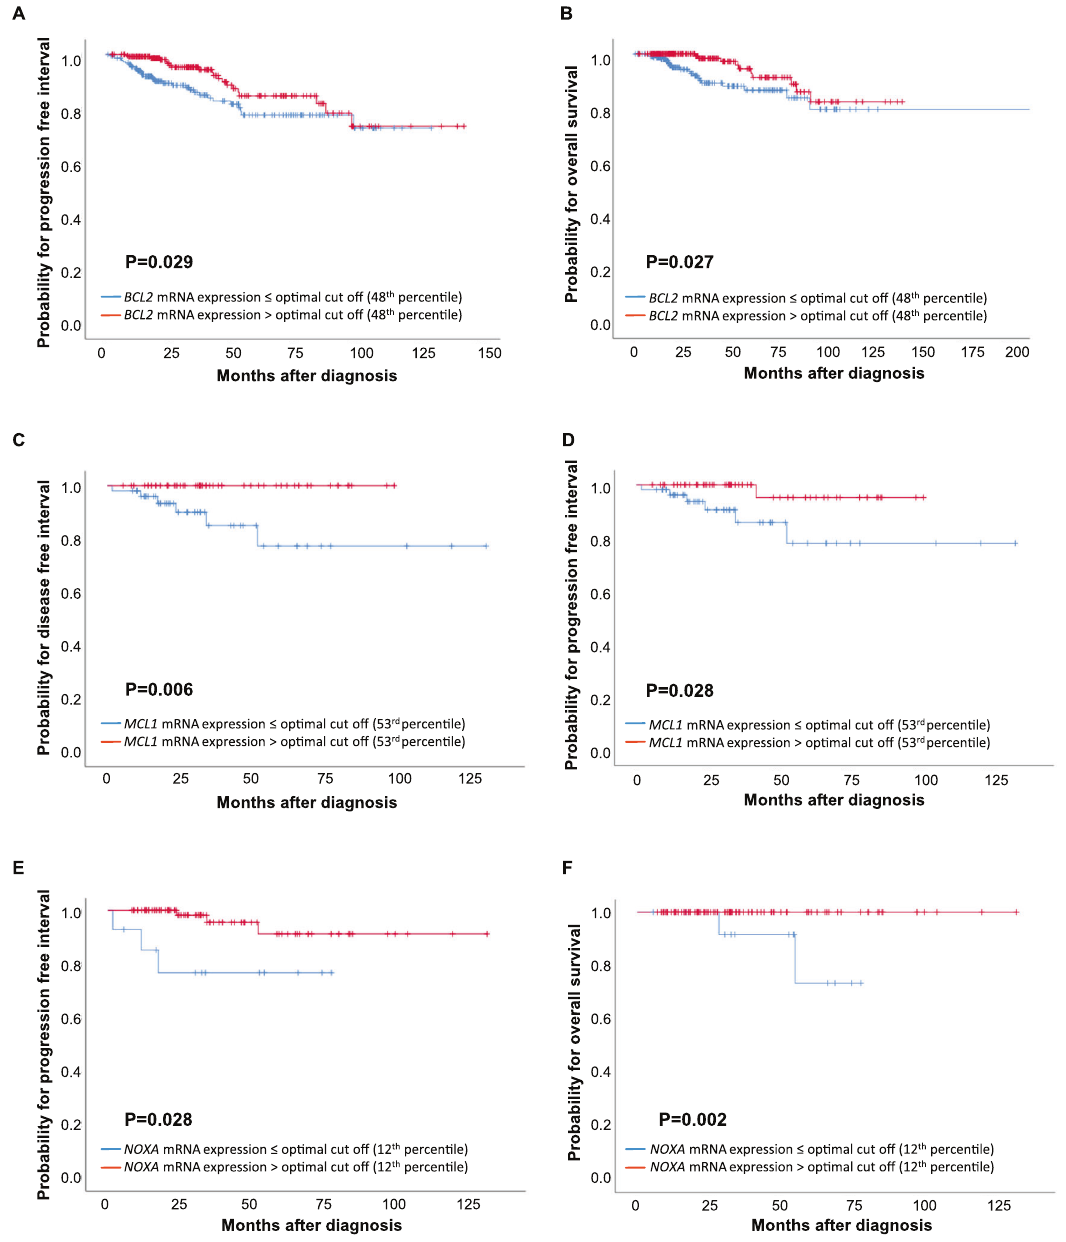
Fig. 2 Kaplan – Meier survival analysis in the TCGA cohort. A PFI and B OS based on BCL2 mRNA-expression in 471 BC patients treated with chemotherapy other than MTA. C DFI and D PFI based on MCL1 mRNA-expression in 112 BC patients treated with MTA chemotherapy. E PFI and F OS based on NOXA mRNA-expression in 112 BC patients treated with MTA